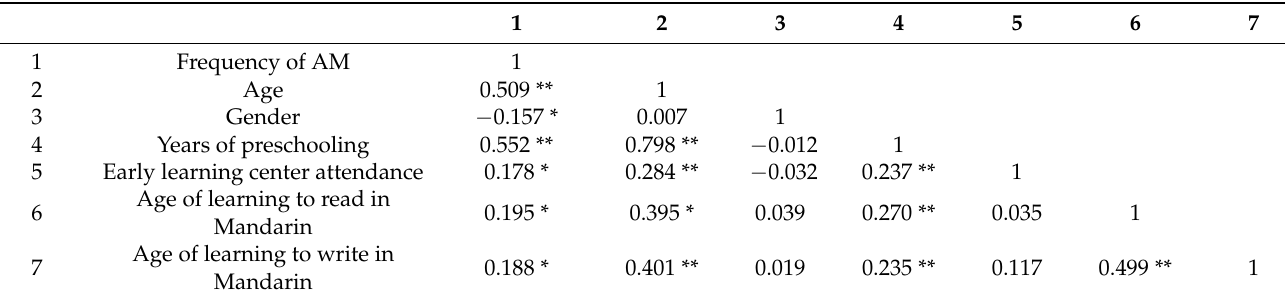
Table 6. Correlation